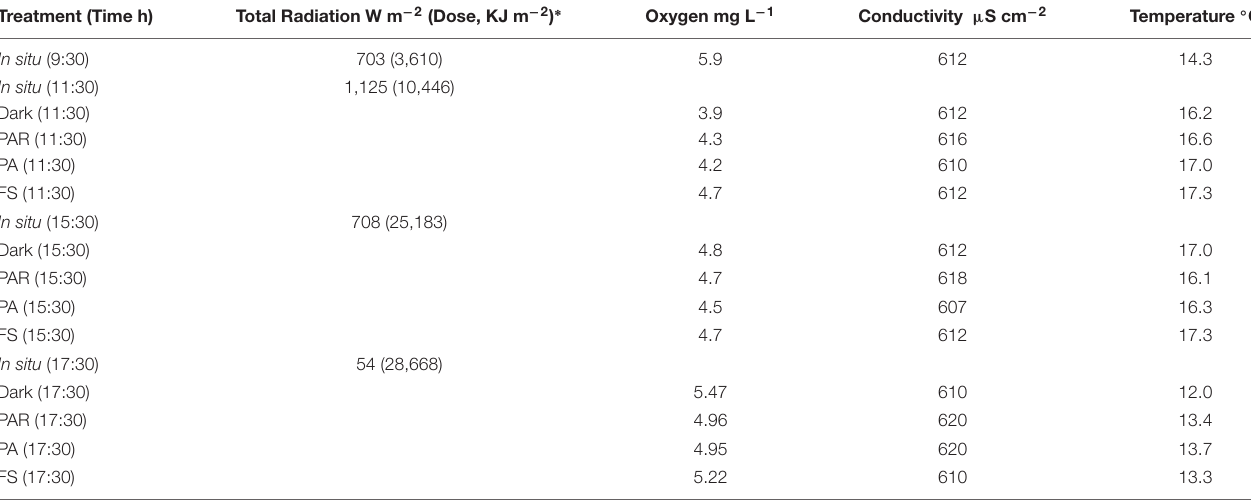
TABLE 1 | Physical and chemical variables determined in situ (i.e., at the start of the experiment) and within the various treatments and incubation times. Treatment (Time